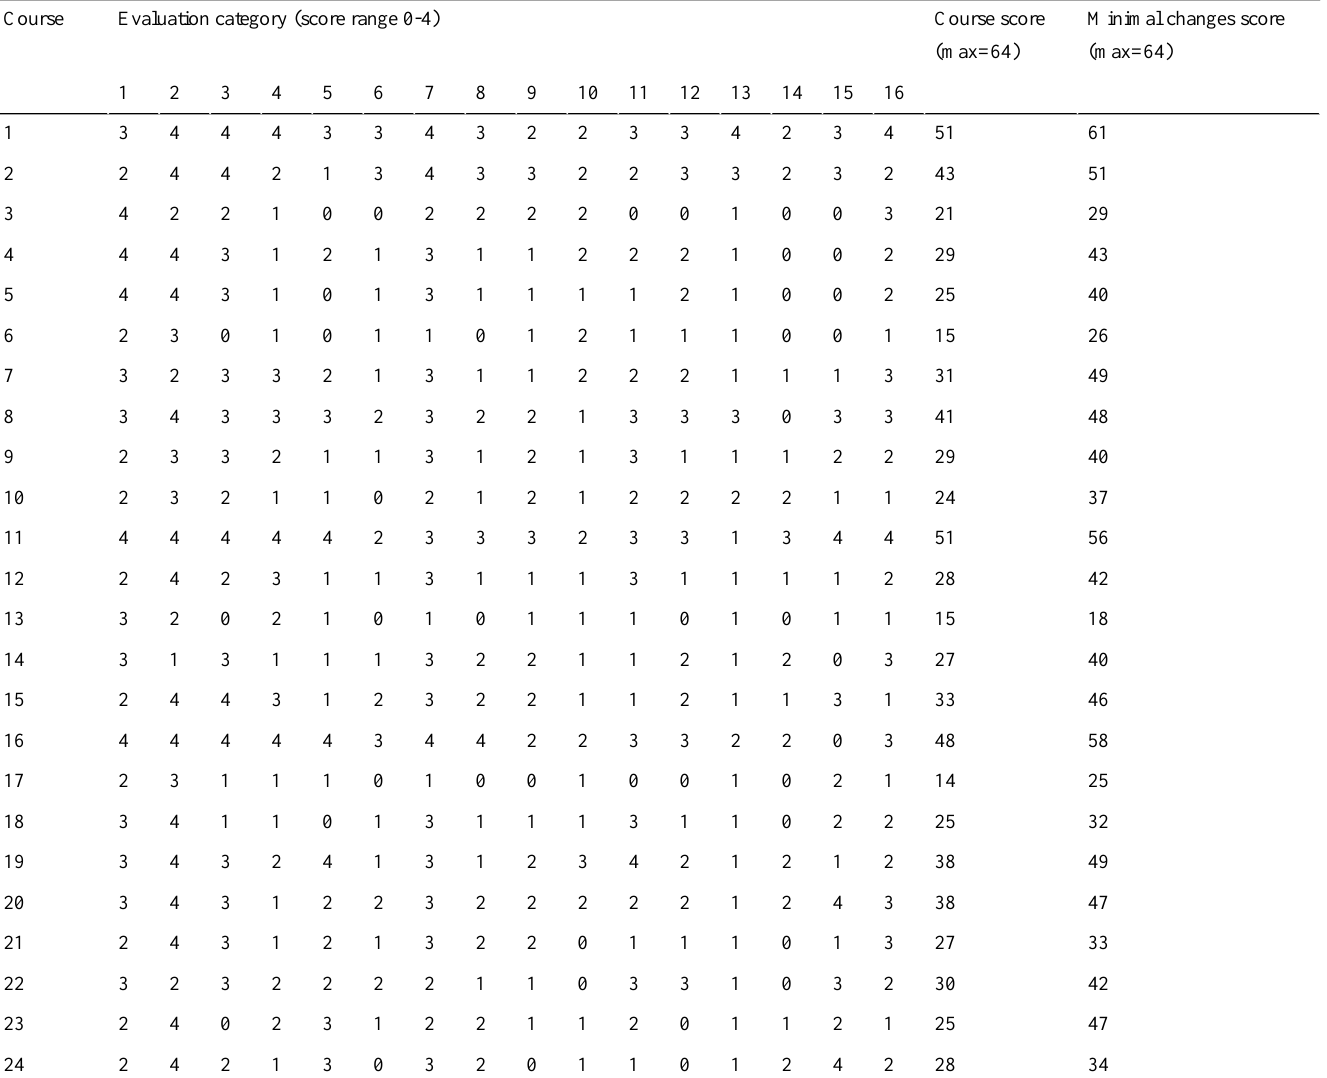
Table 1. Course scores as assessed with the Peer Review Rubric for Online